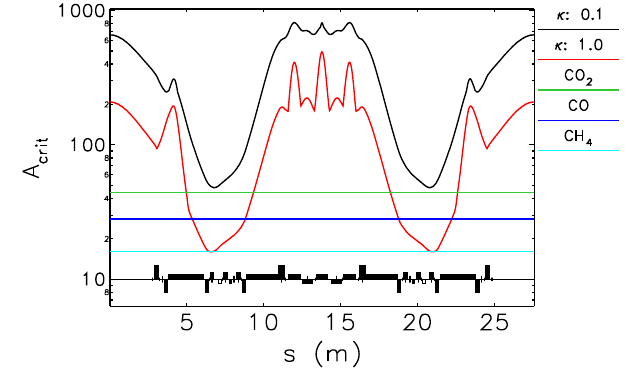
FIG. 2. Critical mass for different emittance ratios ( κ ), com- pared with the mass numbers of common gasses. An ion will be trapped wherever its mass number is larger than the critical mass.